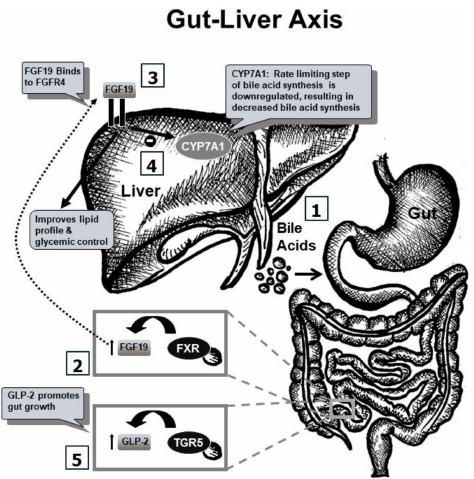
Figure 1. Gut–Liver Axis. 1. Bile acids are secreted into the small intestine and travel through the gut. 2. FXR, with its highest concentration in the terminal ileum, is activated by bile acids. This results in FGF19 secretion into portal circulation. 3. FGF19 binds with its receptor, FGFR4 in hepatocytes. 4. FGF19 regulates CYP7A1, the rate-limiting step of bile acid synthesis, resulting in a decrease in bile acid synthesis, thus, hepatic bile acids are modulated by gut signaling. 5. TGR5 is activated by bile acids, leading to an increase in GLP-2, which promotes gut growth. CYP7A1: Cholesterol 7 alpha-hydroxylase; GLP-2: Glucagon-like peptide 2; FGF19: Fibroblast growth factor 19; FGFR4: Fibroblast growth factor receptor 4; FXR: Farnesoid X receptor; TGR5: Takeda G-protein-coupled receptor